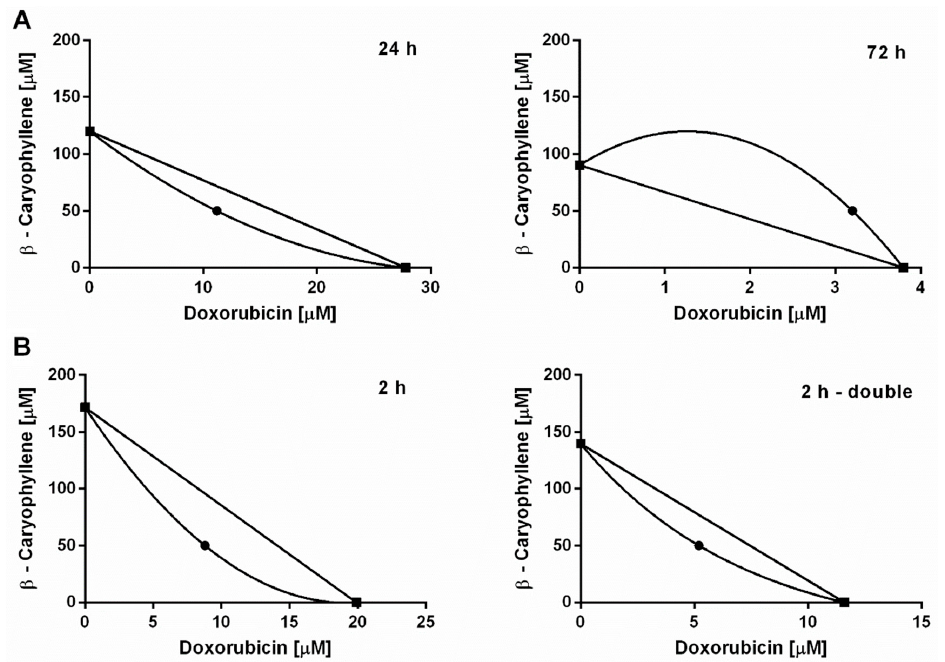
Figure 4. Isobolographic analysis of the cytotoxicity produced by doxorubicin in combination with β -caryophyllene at the chemosensitizing concentrations of 50 µM in Mz-ChA-1 cholangiocarcinoma cells. ( A ) Long-term exposure of 24 h and 72 h. ( B ) Single and double repeated metronomic exposure of 2